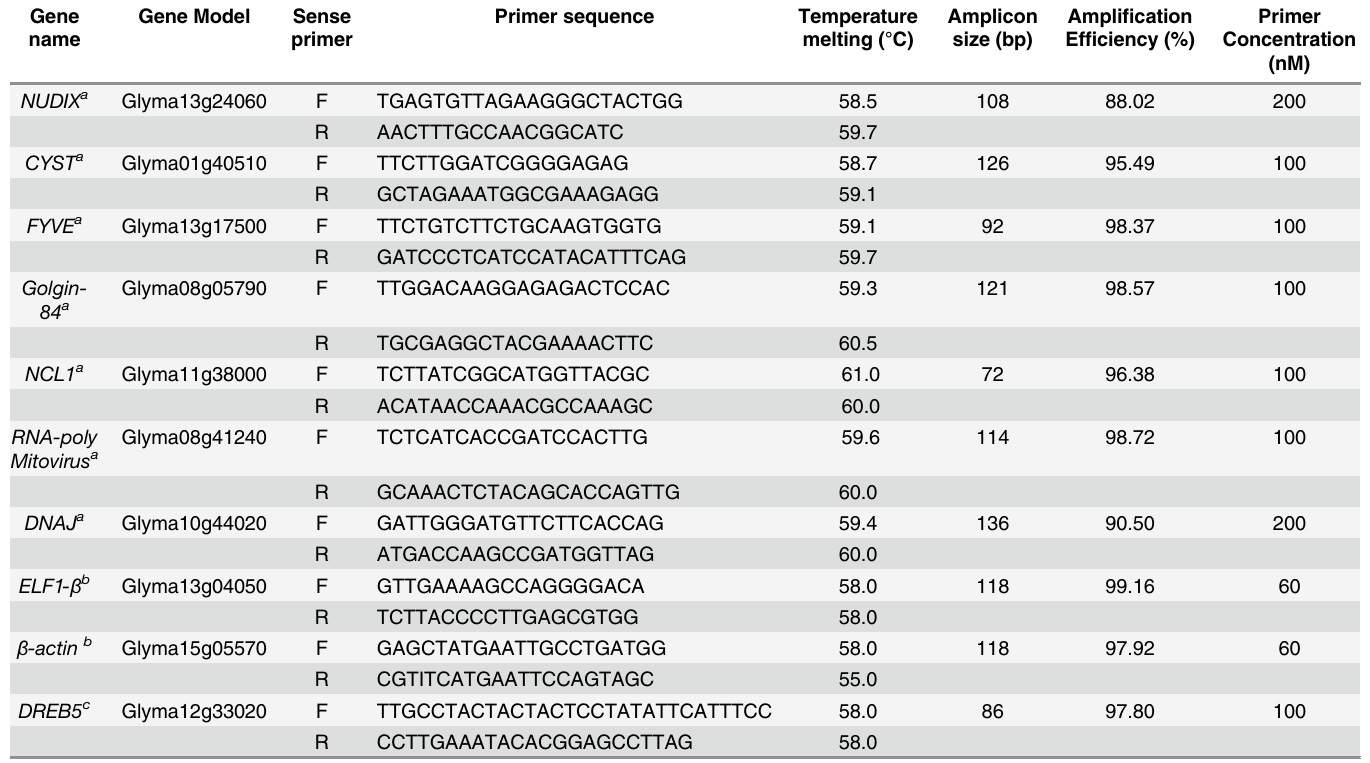
Table 2. Information on reference and target